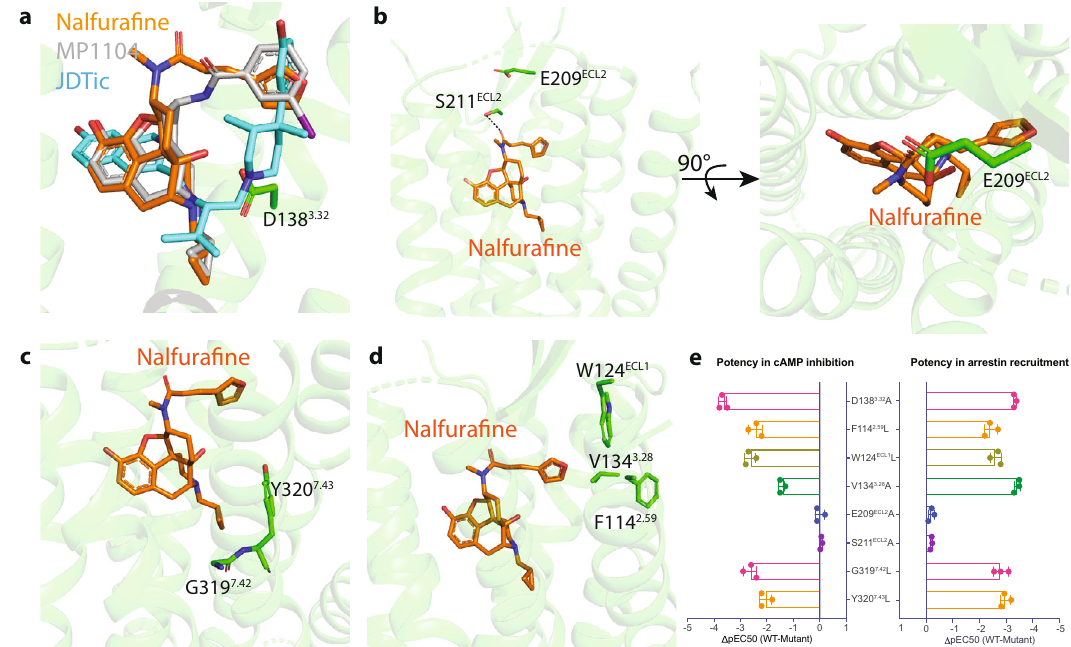
Fig. 2 | Molecular signatures of nalfura fi ne-bound KOR. a Alignment of the antagonist JDTic, agonist MP1104, and nalfura fi ne in the binding pocket of KOR. b The residue E209 ECL2 forms a lid on the top of nalfura fi ne. c The interaction between the cyclopropyl methyl group of nalfura fi ne and hydrophobic pocket residues. d The furan ring of nalfura fi ne forms unique interaction with the ‘ triad ’